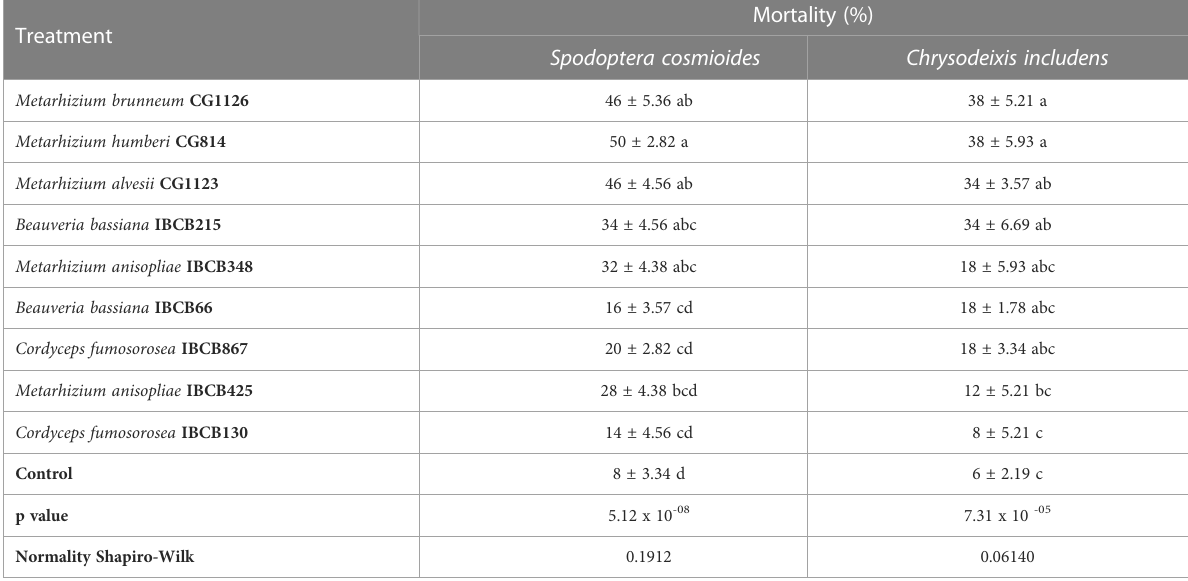
TABLE 6 Mortality (%) of S. cosmioides and C. includens fed peanut plants inoculated with entomopathogenic fungi and the uninoculated control.